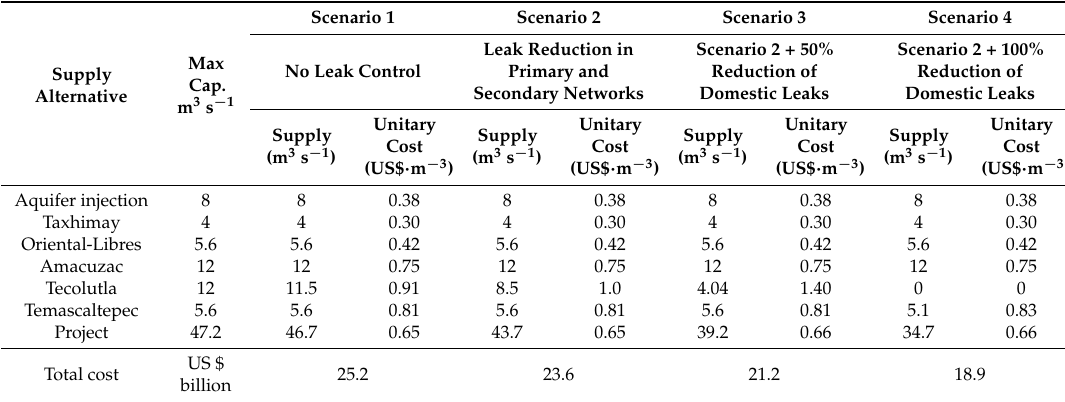
Table 8. Total and unitary costs for replacing groundwater extraction from the aquifer system of Central Mexico in four scenarios for leak